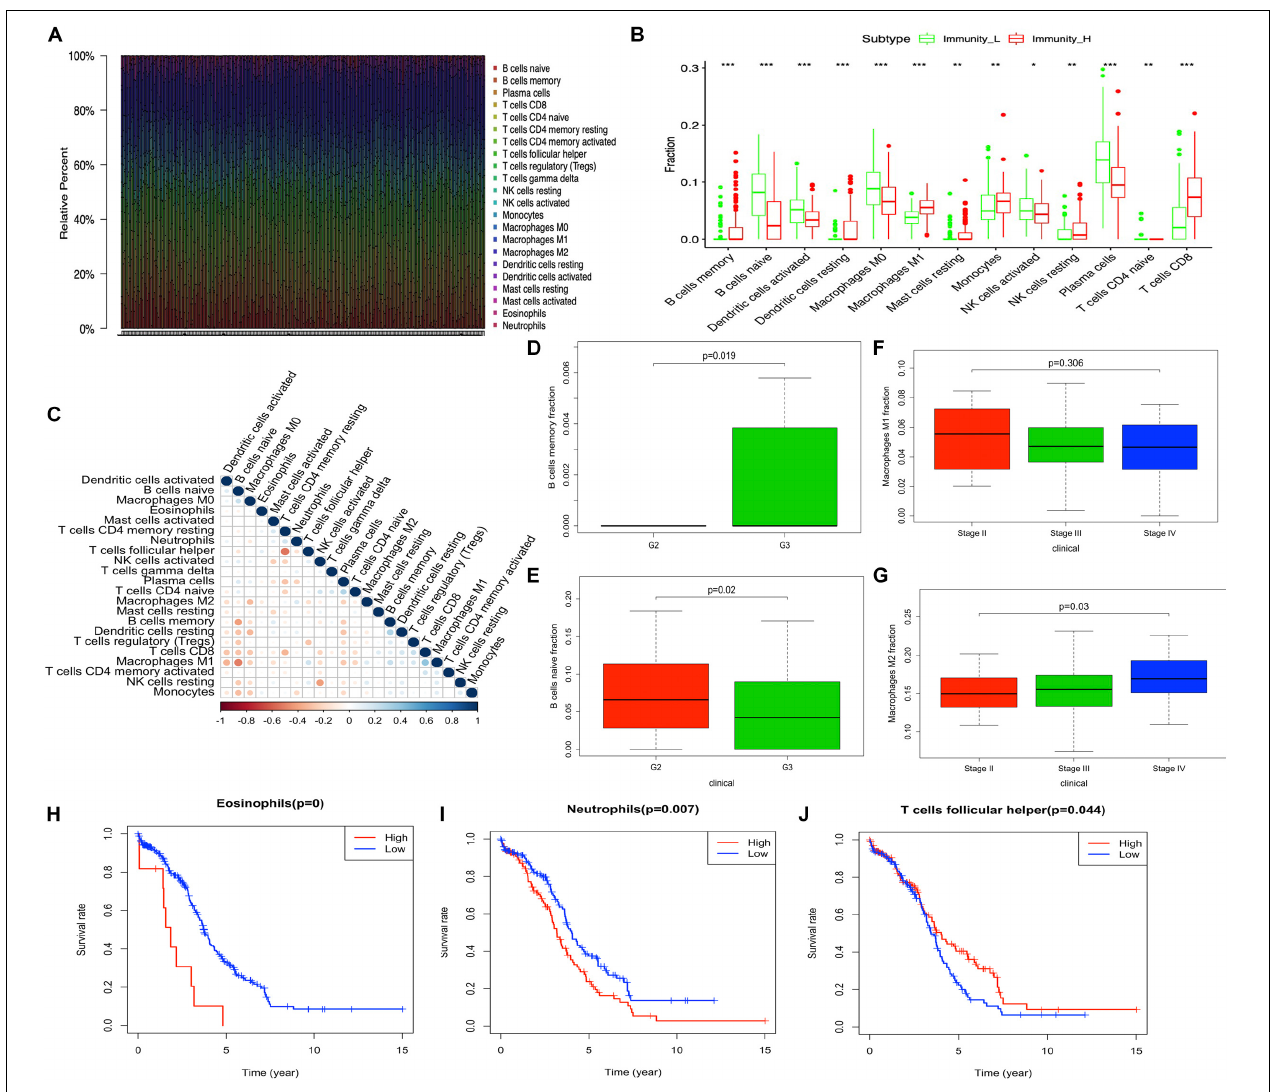
FIGURE 2 | The distribution of immune cells between high- and low-abundance immune groups and corresponding clinical features. (A) Barplot showing the proportion of 22 kinds of immune cells in OC samples. Column names of the plot are the sample ID. (B) Boxplot shows the ratio differentiation of 13 kinds of immune cells between high- and low-abundance immune groups, and the Wilcoxon rank sum was used for the significance test. (C) Heatmap showing the correlation between 22 kinds of immune cells and numeric in each tiny box indicating the p -value of the correlation between two kinds of cells. The shade of each tiny color box represents the corresponding correlation value between two cells, and the Pearson coefficient was used for significance test. (D,E) The correlation of B cells memory and B cells naïve with clinicopathological grade characteristics. Wilcoxon rank sum or Kruskal–Wallis rank sum test served as the statistical significance test. (F,G) The correlation of M1 macrophages and M2 macrophages with clinicopathological stage characteristics. Wilcoxon rank sum or Kruskal–Wallis rank sum test served as the statistical significance test. (H–J) Kaplan–Meier survival analysis for Eosinophils, neutrophils, and T cells follicular helper in OC. A comparison with the median determined immune cell group. P -value was verified by log-rank test. * p < 0.05, ** p < 0.01, and *** p <